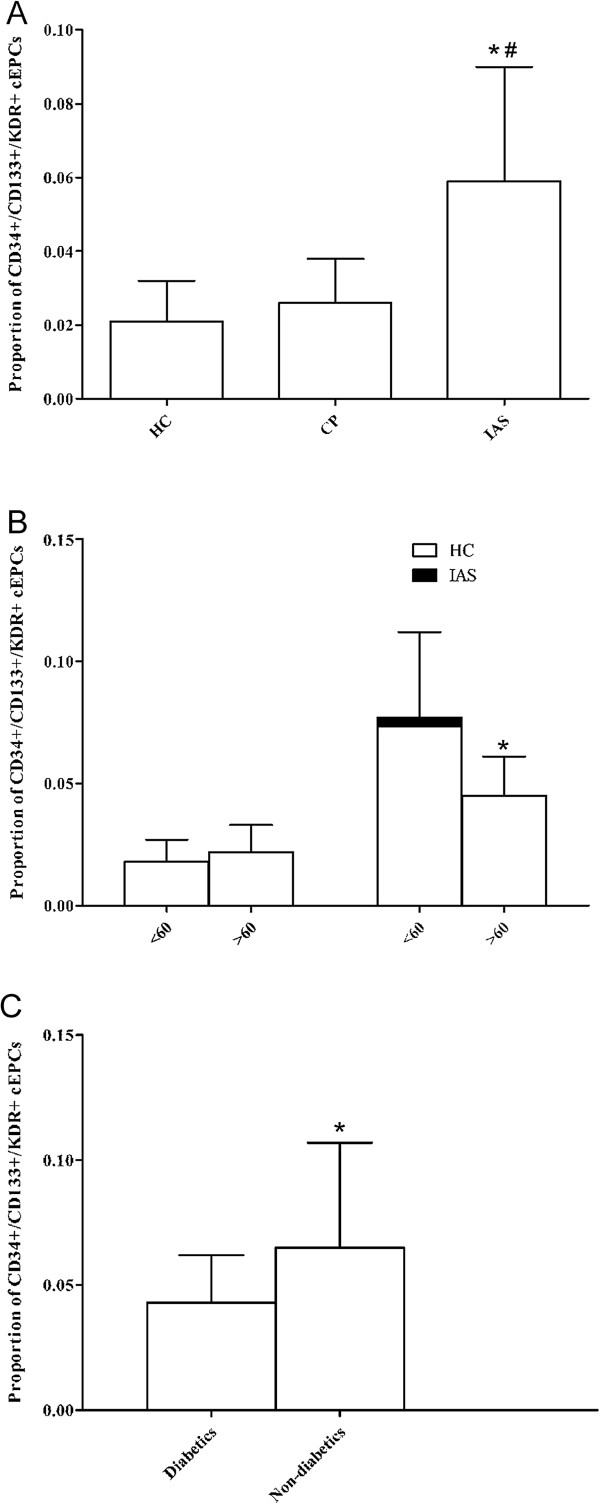
cEPCs proportions across different groups. (A) cEPC levels in the peripheral blood of HC, CP and IAS (*P < 0.01, IAS vs. HC; # P < 0.01, IAS vs. CP). Rresults are presented as mean ± SD. (B) Differences in cEPC levels in the peripheral blood of HC and IAS according to age (*P < 0.05, <60 vs. ≥60 years old in IAS patients). Results are presented as mean ± SD. (C) Differences in cEPCs levels of IAS according to the diabetes status (*P < 0.05 vs. diabetics).